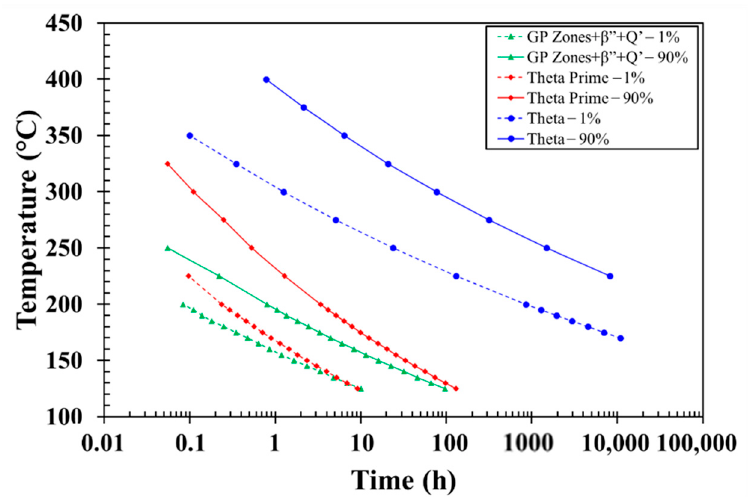
Figure 10. TTT diagram for precipitation in AlSi7Cu3.5Mg0.15 (Mn, Zr, V) alloy according to [33].